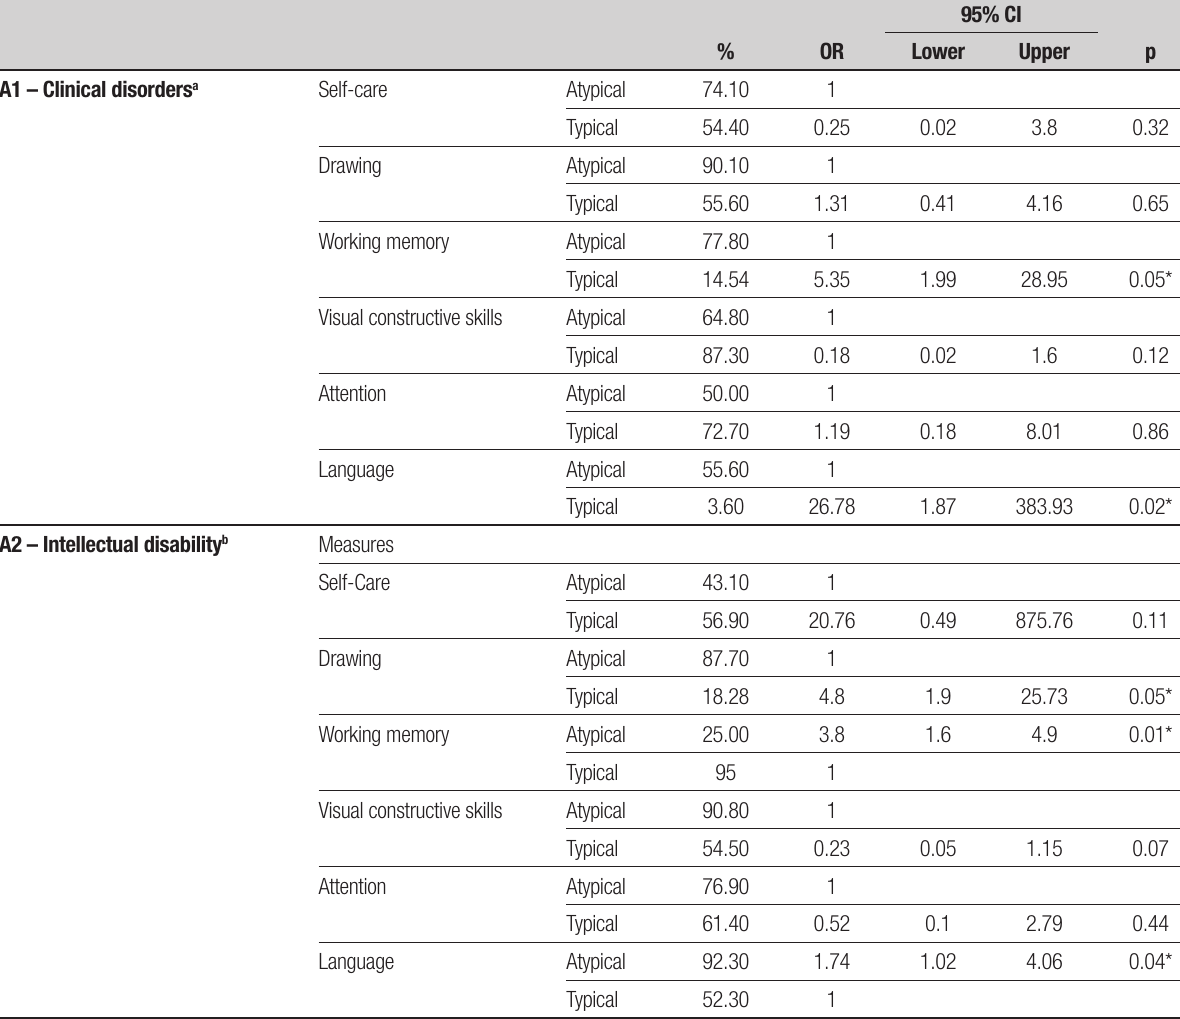
Table 3. Logistic regression (with frequencies) and odds ratio calculated for each of the six measures and significant association with diagnostic axes 1 and 2.